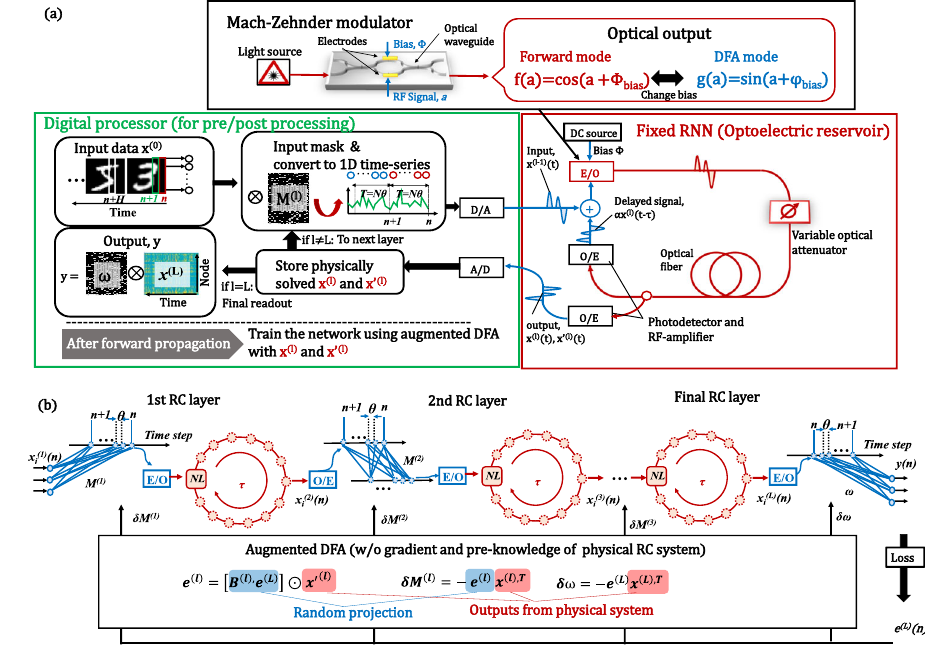
Fig. 3 | Optoelectronic deep RC system with augmented DFA training. a Schematic of the constructed optoelectronic deep RC. The input signals are masked by a digital processor and sent to the optoelectronic RC system to solve Eqs. (4) and (5). The change in the nonlinearity from f ( a ) to g ( a ) is realized